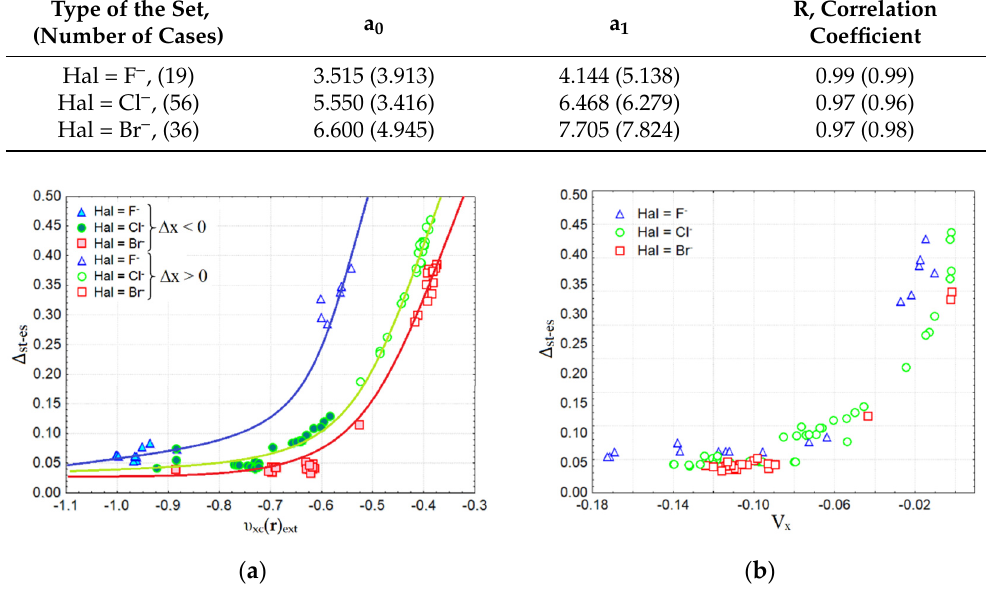
Figure 6. Relationships between the gap ∆ st-es along interatomic line Hal − …Tt and the exchange-correlation contribution υ xc ( r ) ext in the static potential at extrema of υ es ( r ) min and υ st ( r ) max ( a ) and with the bond contribution to exchange energy, V x ( b ). Table 1. Parameters of Equation (7) describing relationship between the gap ∆ st-es (Å) along intera- tomic line Hal – …Tt and the contribution of exchange-correlation potential υ xc ( r ), (a.u.) estimated on the base of extremes of potentials and at the critical points of electron density (in brackets). Type of the Set,